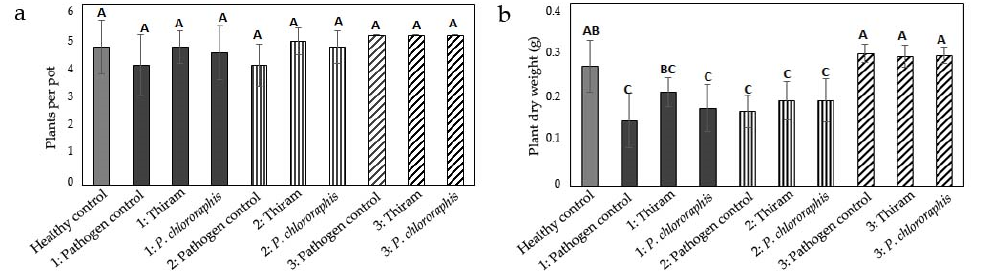
Figure 1. Effect of position of inoculum of Globisporangium ultimum on ( a ) number and ( b ) biomass of maize seedlings and on efficacy of seed treatment with thiram or a suspension of Pseudomonas chlororaphis aurantiaca BI 7439. Variant 1: inoculum of G. ultimum distributed homogenously in the entire pot volume; variant 2: inoculum of G. ultimum present only in the upper half of pots; variant 3: inoculum of G. ultimum present only in the lower half of pots. Means and standard deviation of five pots per treatment with five maize seeds each. Different letters above bars indicate statistically significant differences between the treatments (GLMM; p < 0.05).